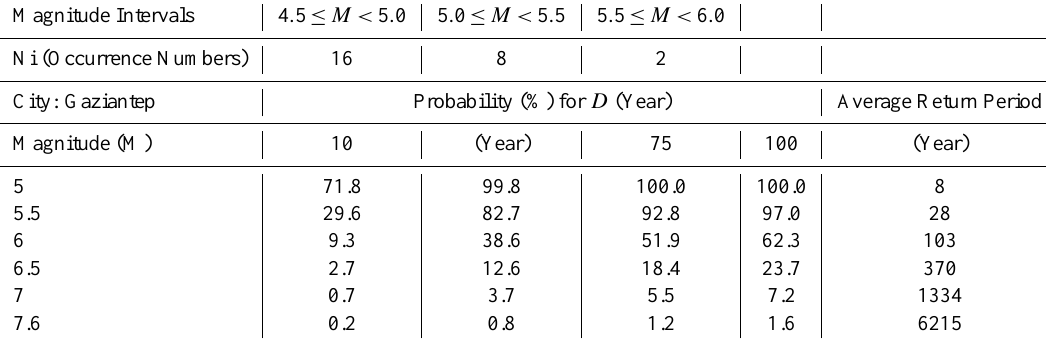
Table 3j. Earthquake occurrence probability (%) for D (Year) for Gaziantep city. Magnitude Intervals